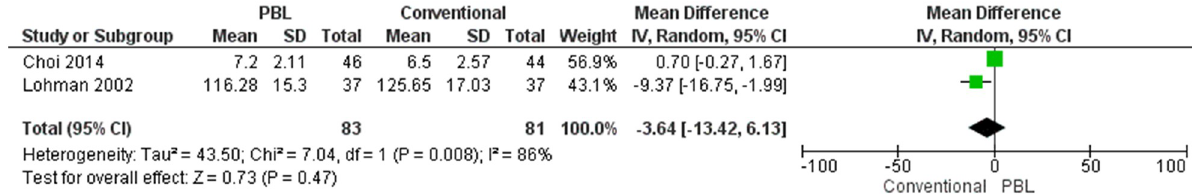
Fig 4. Evaluation of problem-solving aspect of conventional teaching vs. PBL.